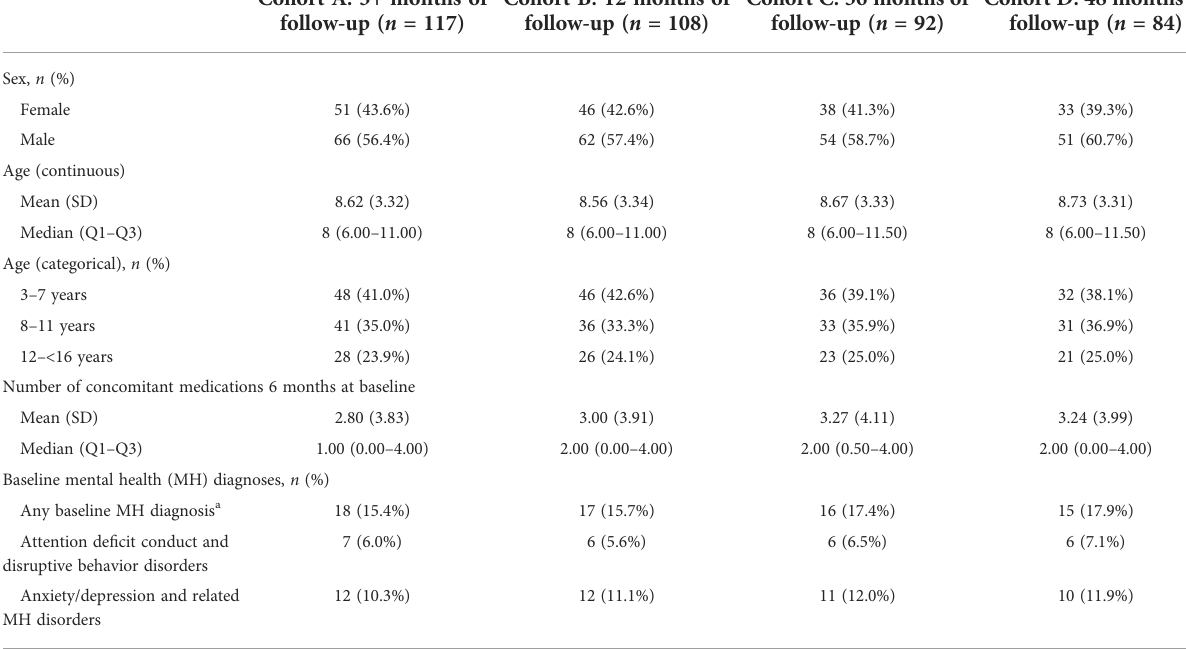
TABLE 1 Baseline demographic and clinical characteristics of children ( ≥ 3 and < 16 years) with pGHD treated with daily somatropin in the UK. Cohort A: 3+ months of Cohort B: 12 months of follow-up ( n = 117) follow-up ( n = 108)